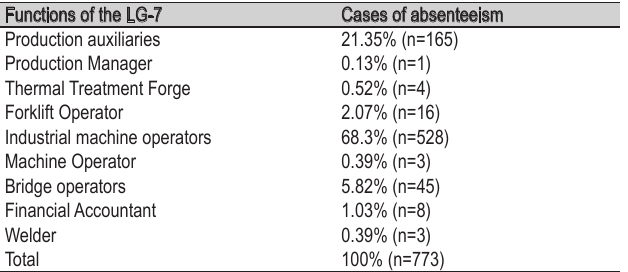
Table 2 - Distribution of cases of absenteeism in relation to the